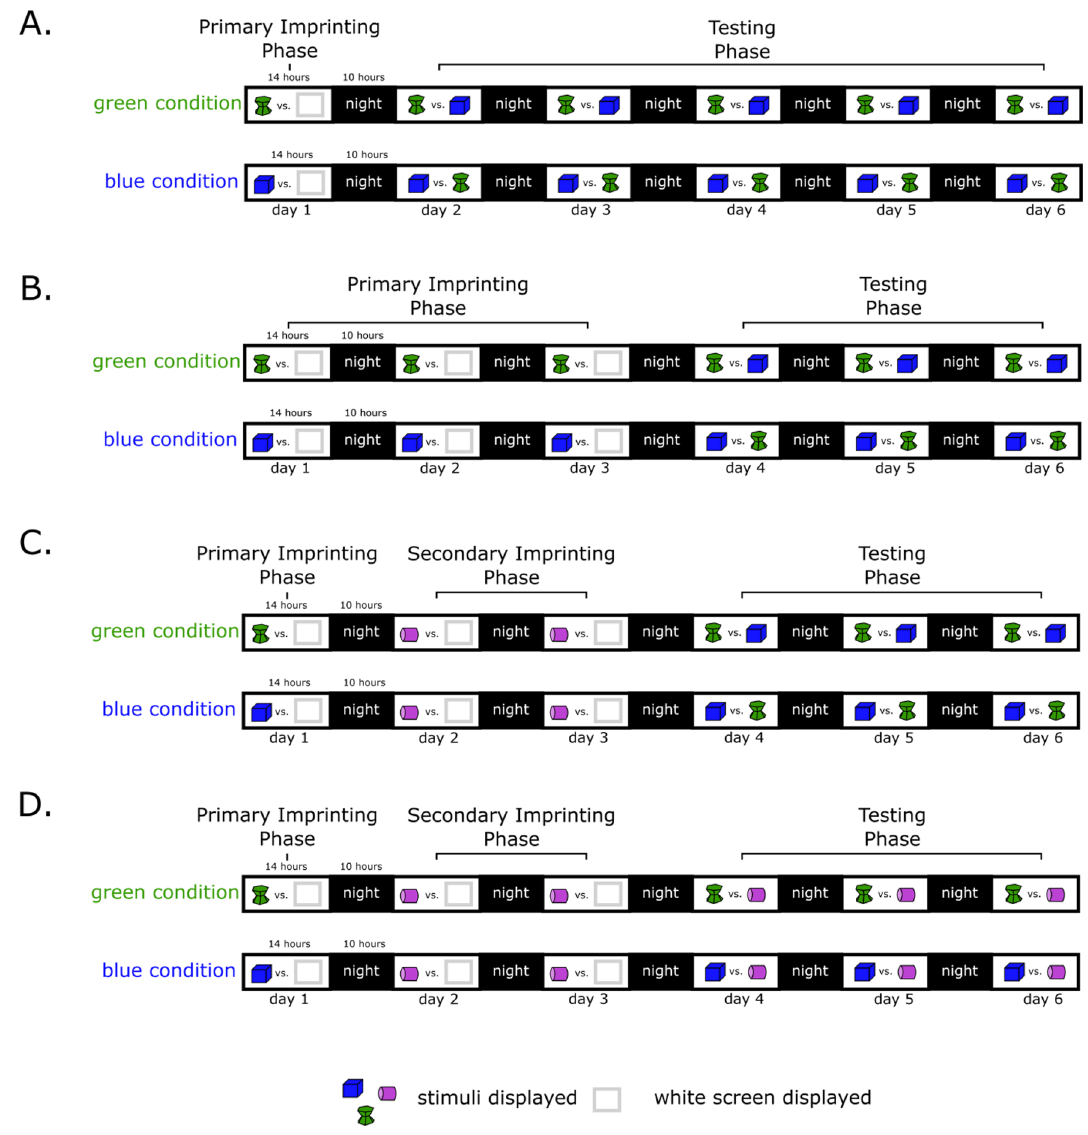
Figure 6. Experimental timelines of experiment 1 ( A ), 2 ( B ), 3 ( C ) and 4 ( D